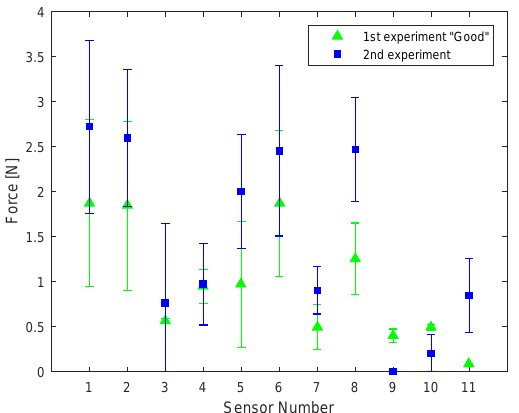
Figure 7: Average and variance of the force measured on each sen- sor for the ideal hand grip chosen by the subjects (blue), and the average of the hand grip evaluated as “good” (green) in the experi- ment of Section 4 (Figure